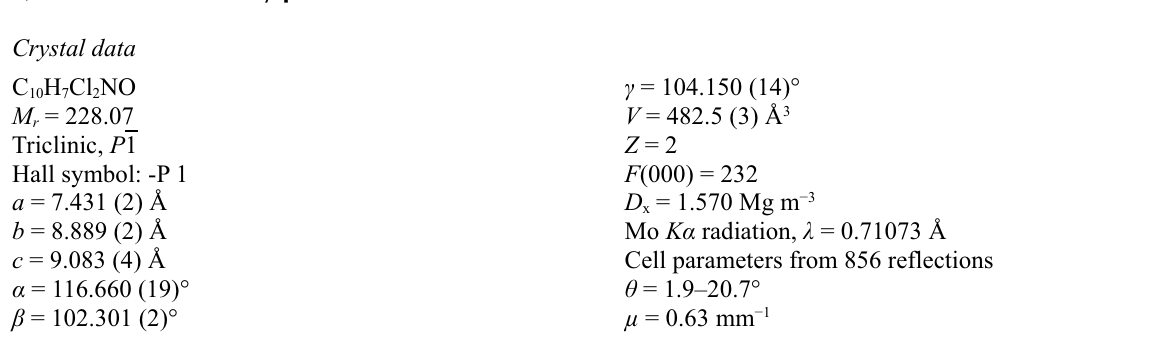
The crystal packing diagram of the title compound. The dotted lines indicate π – π interactions. All H atoms have been omitted for